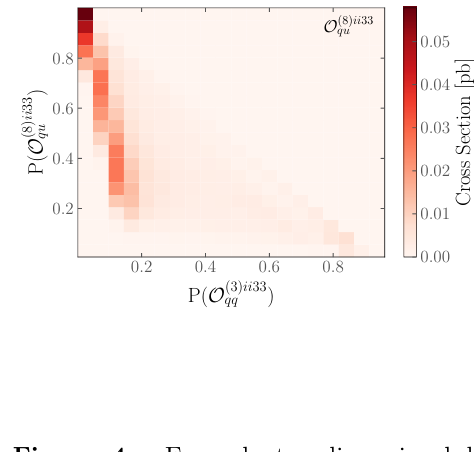
Figure 4 . Example two-dimensional his- tograms for each contribution, normalised to the cross section rate.